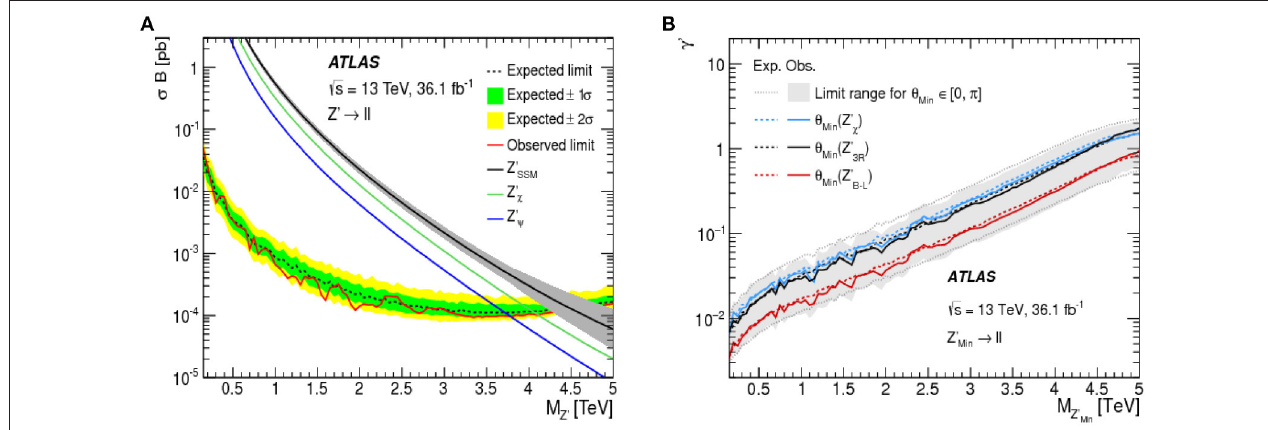
Z ′ ℓ + ℓ − by ATLAS at √ s → → ′